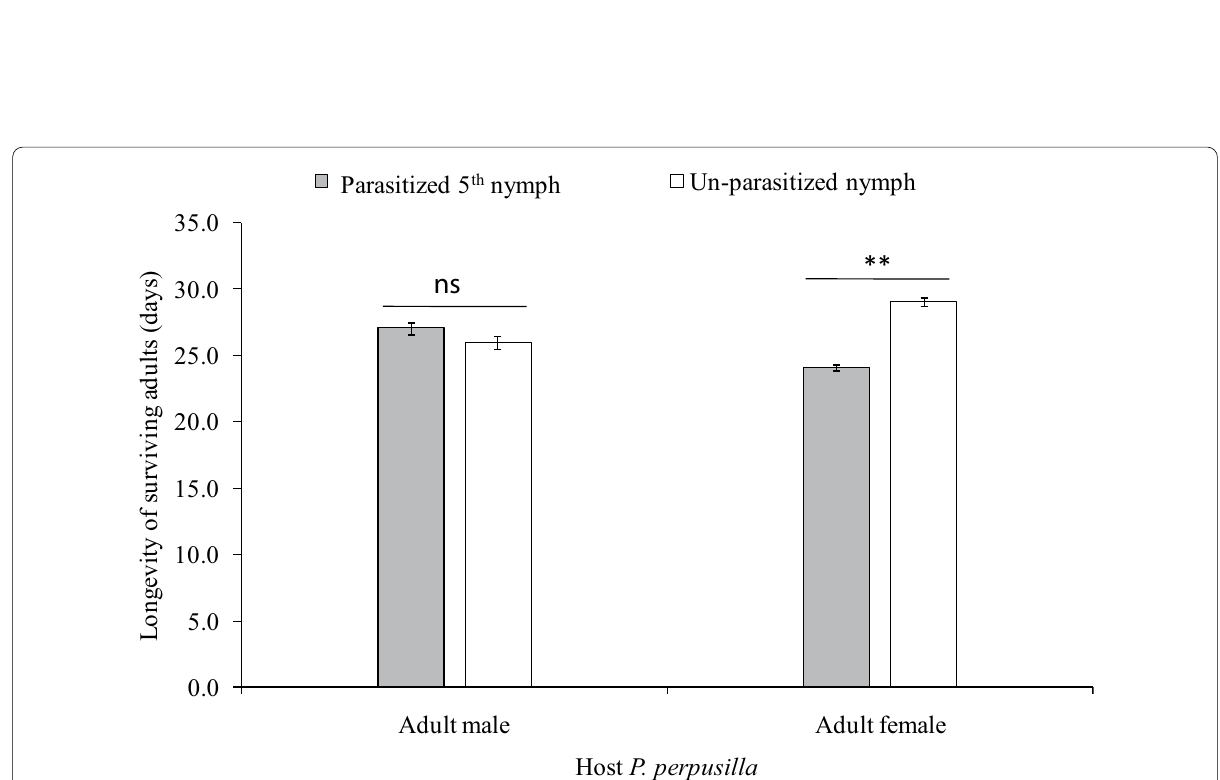
Fig. 3 Longevity of surviving adults (male and female) of P. perpusilla from parasitized and un-parasitized 5th nymphal stage; “**” and “ns” within a column indicate ( p < 0.05) significant difference and no difference, respectively; the results are presented as the means